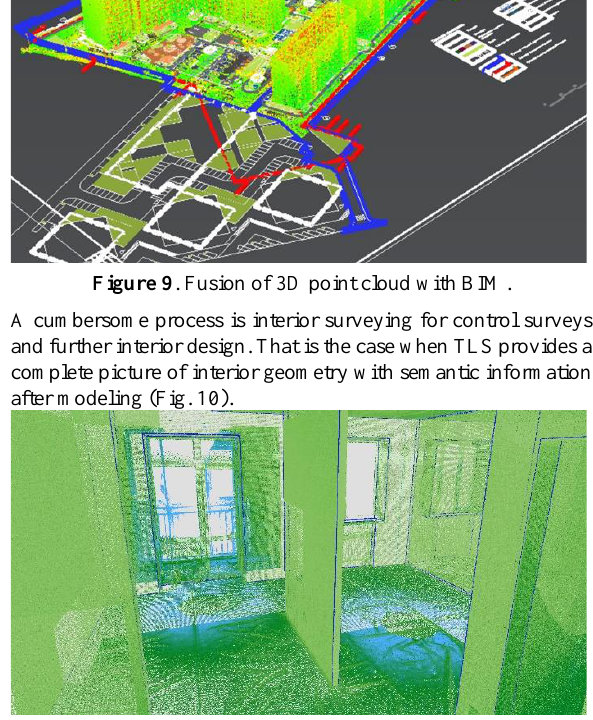
Figure 10 . 3D point cloud with basic interior elements.